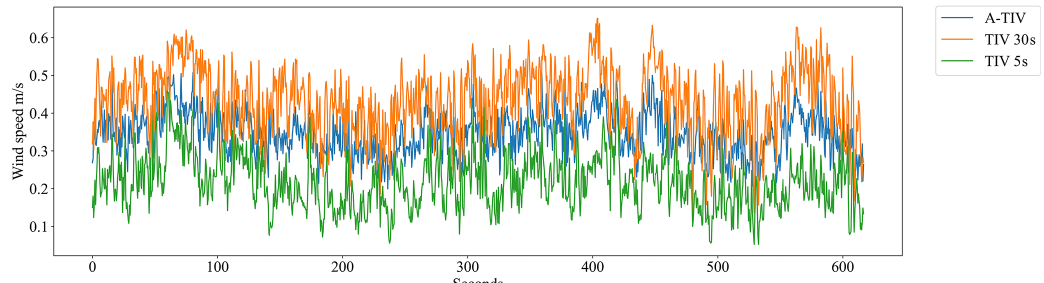
Figure B1. Qualitative comparison of A-TIV wind speeds to TIV wind speeds of TURF-T1. The speeds are averaged over the entire area of the turf field. TIV speeds from the perturbation filters 10 and 20s would be located between the 5 and the 30s wind speeds and are not shown in this